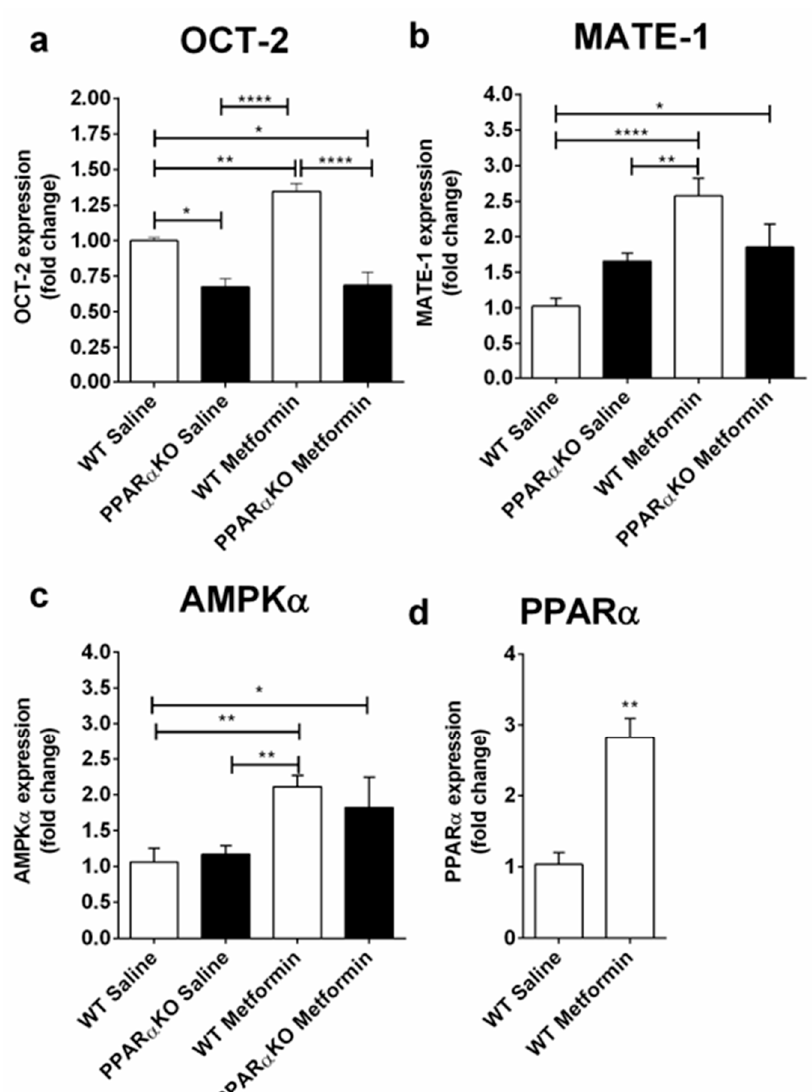
Figure 1. Real-Time PCR of OCT-2 ( a ), MATE-1 ( b ), AMPK α ( c ) and proliferator-activated receptor alpha (PPAR α ) ( d ) in the kidney of mice treated with saline or metformin (300 mg/kg) for 30 days. Data was compared by Two-Way ANOVA and Tukey multiple comparisons test ( a – c ), or unpaired, nonparametric Mann-Whitney test ( d ); * p < 0.05, ** p < 0.01, *** p < 0.001, **** p < 0.0001. Data are presented as Mean ± S.E.M.